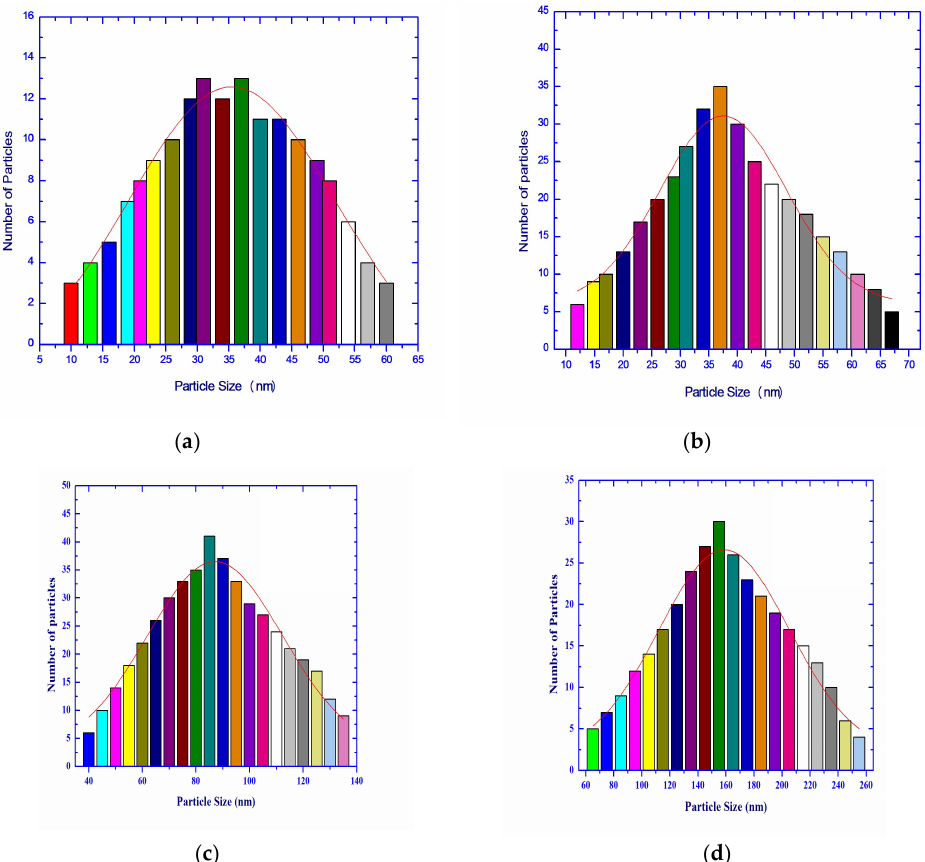
Figure 5. Histograms of particle size distribution based on SEM micrographs images for the prepared samples; ( a ) S1, ( b ) S2, ( c ) S3 and ( d ) S4 samples.